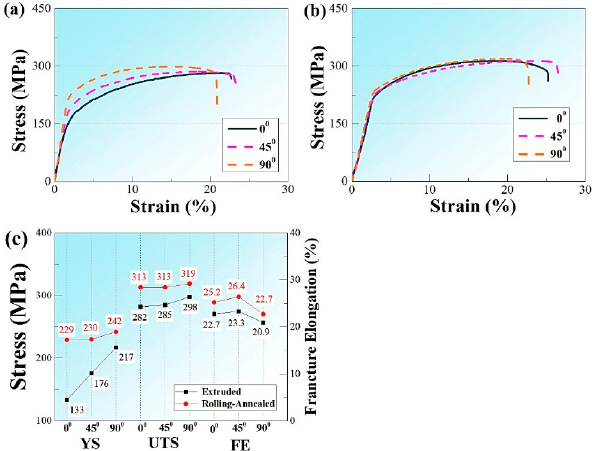
Figure 7. Mechanical properties of ATM610 alloy sheets. ( a ) extruded sample, ( b ) rolling-annealed sample, and ( c ) statistical data.